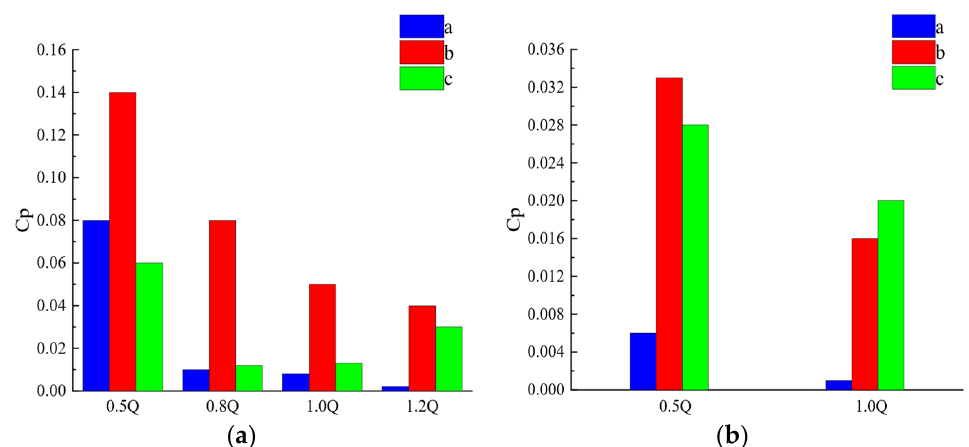
Figure 9. Pressure pulsation peak ‐ to ‐ peak. ( a ) Run forward. ( b ) Run in reverse. Fourier transform was performed on the previously selected pressure pulsation data.